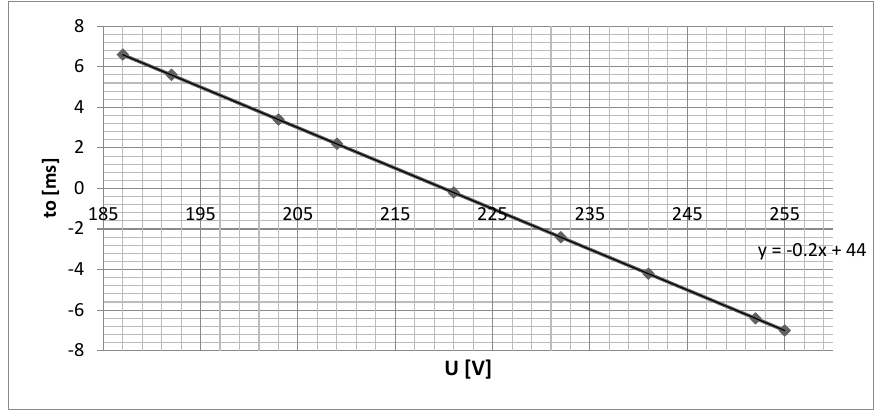
Figure 21 represents the dependency of parameter t UDC on the DC voltage supply on the connection of a circuit breaker.